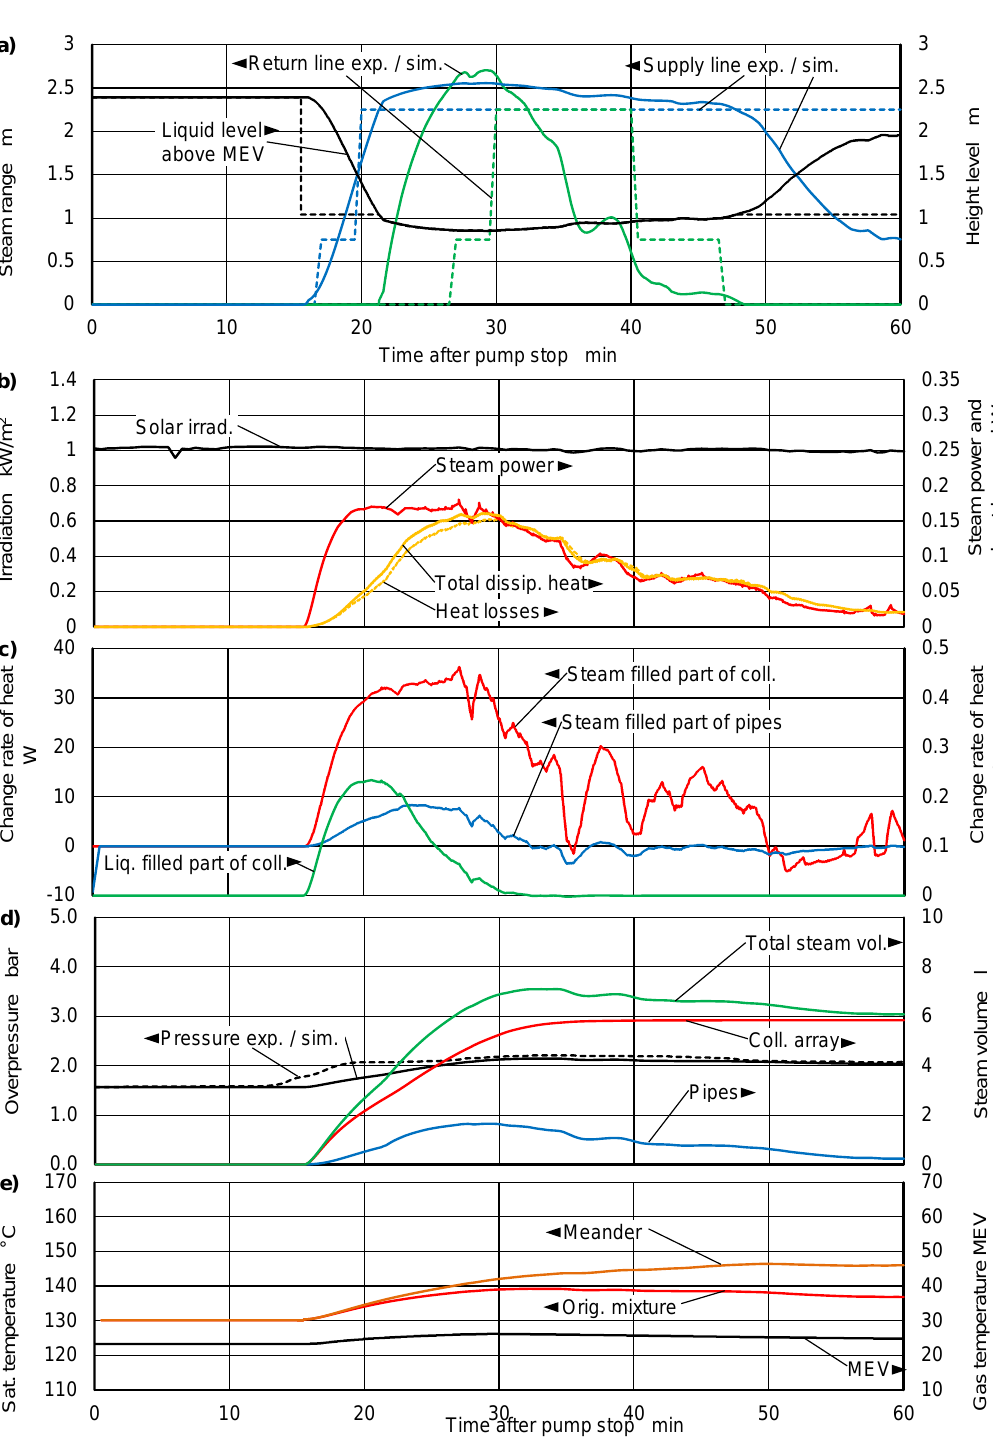
Figure 14. Experimental and simulation results for the system with thermochromic absorbers. Inactive check valves. Dataset 08−16. ( a ) Steam range and level height, ( b ) Steam power, heat losses and irradiation, ( c ) Change rates of heat, ( d ) Overpressure and steam volume, ( e ) Saturation temperature and gas temperature inside MEV.